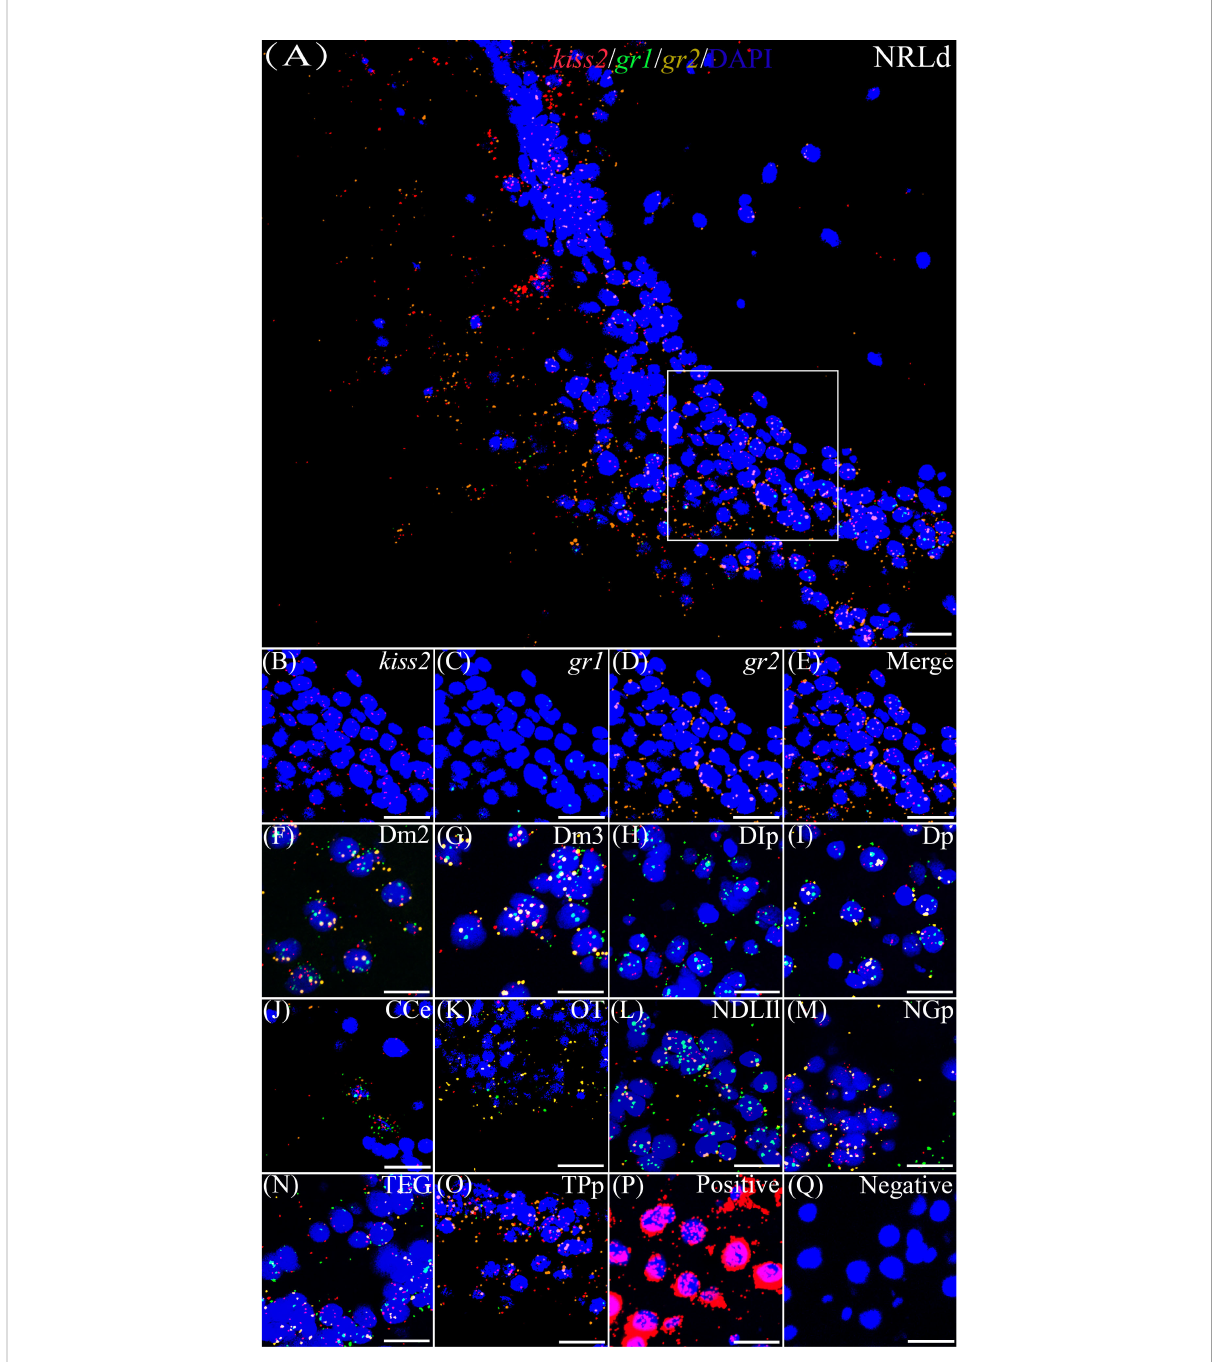
FIGURE 3 Co-expression of gr1 , gr2 , and kiss2 . The view of NRLd (A) shows kiss2 (red), gr1 (green), and gr2 (yellow) with DAPI cell nuclear staining (blue). (B – E) The view of boxed region in panel (A) , showing kiss2 (red), gr1 (green), and gr2 (yellow) with DAPI cell nuclear staining (blue) in panels (B – D) , respectively; and the “ merge ” in panel (E) shows kiss2 (red), gr1 (green), and gr2 (yellow) with DAPI cell nuclear staining (blue). Representative images display gr1 (green) and gr2 (yellow) co-expression of kiss2 (red) with DAPI cell nuclear staining (blue) in Dm2 (F) , Dm3 (G) , DIp (H) , Dp (I) , CCe (J) , OT (K) , NDLIl (L) , NGp (M) , TEG (N) , and TPp (O) . Positive and negative controls are shown in panels (P , Q) , respectively. NRLd, dorsal part of the nucleus of the lateral recess; Dm2, subdivision 2 of the medial dorsal telencephalic area; Dm3, subdivision 3 of the medial dorsal telencephalic area; DIp, lateral posterior part of the dorsal telencephalic area; Dp, posterior portion of the dorsal telencephalon; CCe, corpus of the cerebellum; OT, optic tectum; NDLIl, lateral part of the diffuse nucleus of the inferior lobe; NGp, posterior part of glomerular nucleus; TEG, tegmentum; TPp, periventricular nucleus of the posterior tuberculum. Bars = 20 m